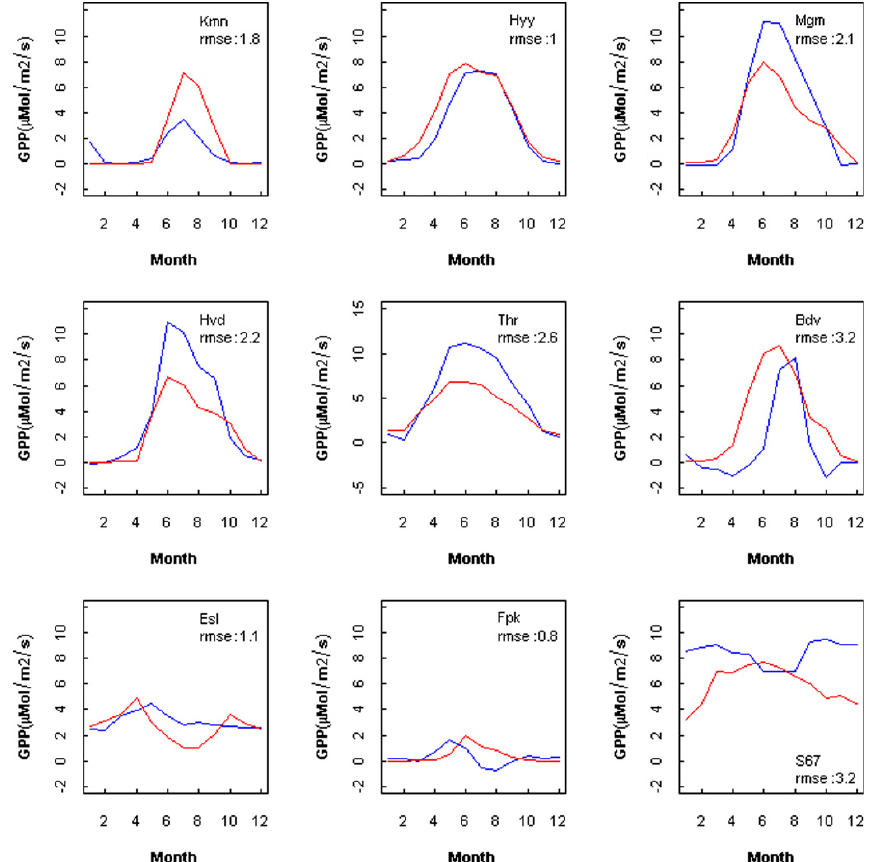
Fig. 3. Modelled (red) and observed (blue) GPP fluxes at 9 FLUXNET sites (Kmn: Kaamanen, Hyy: Hyytiala, Mgn: Morgon Monroe, Hvd: Harvard Forest, Trt: Tharandt, Bdv: Bondville, Els: El Saler, Fpk: Fort Peck, S67: Santarem